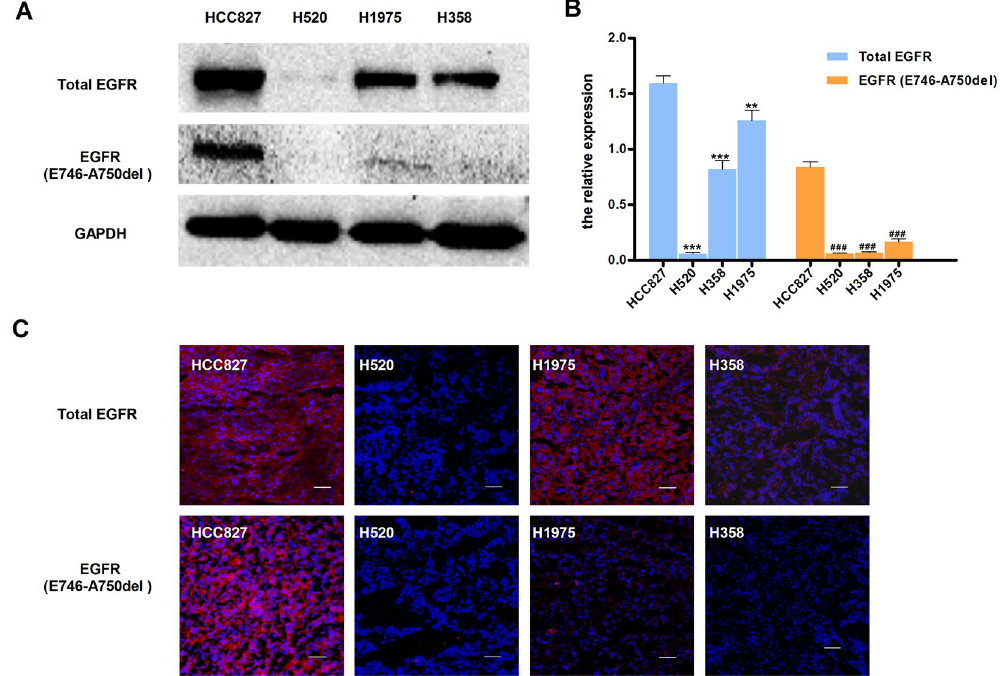
Figure 5. Western blot and immunofluorescence of tumors derived from HCC827, H520, H1975 and H358 cell lines. ( A ) Representative Western blots of four human NSCLC tissue lysates comparing the extent of EGFR and EGFR-specific E749-A750del mutation expression. GAPDH served as a reference for equal loading. HCC827 tissue has high EGFR and EGFR-specific E749-A750del mutation EGFR ( B ) Western blot analysis of proteins in EGFR and EGFR-specific E749-A750del mutation (n = 3). Data are presented as mean ± SD. ** P < 0.01 vs. HCC827 group in total EGFR. *** P < 0.001 vs. HCC827 group in total EGFR. ### P < 0.001 vs. HCC827 group in EGFR EGFR-specific E749-A750del mutation.( C ) The immunofluorescence in tumors confirms western blot results. (Red color is from secondary antibody Alexa Fluor ® 549, and blue color from DAPI for nuclear visualization). All scale bars, 100 μ